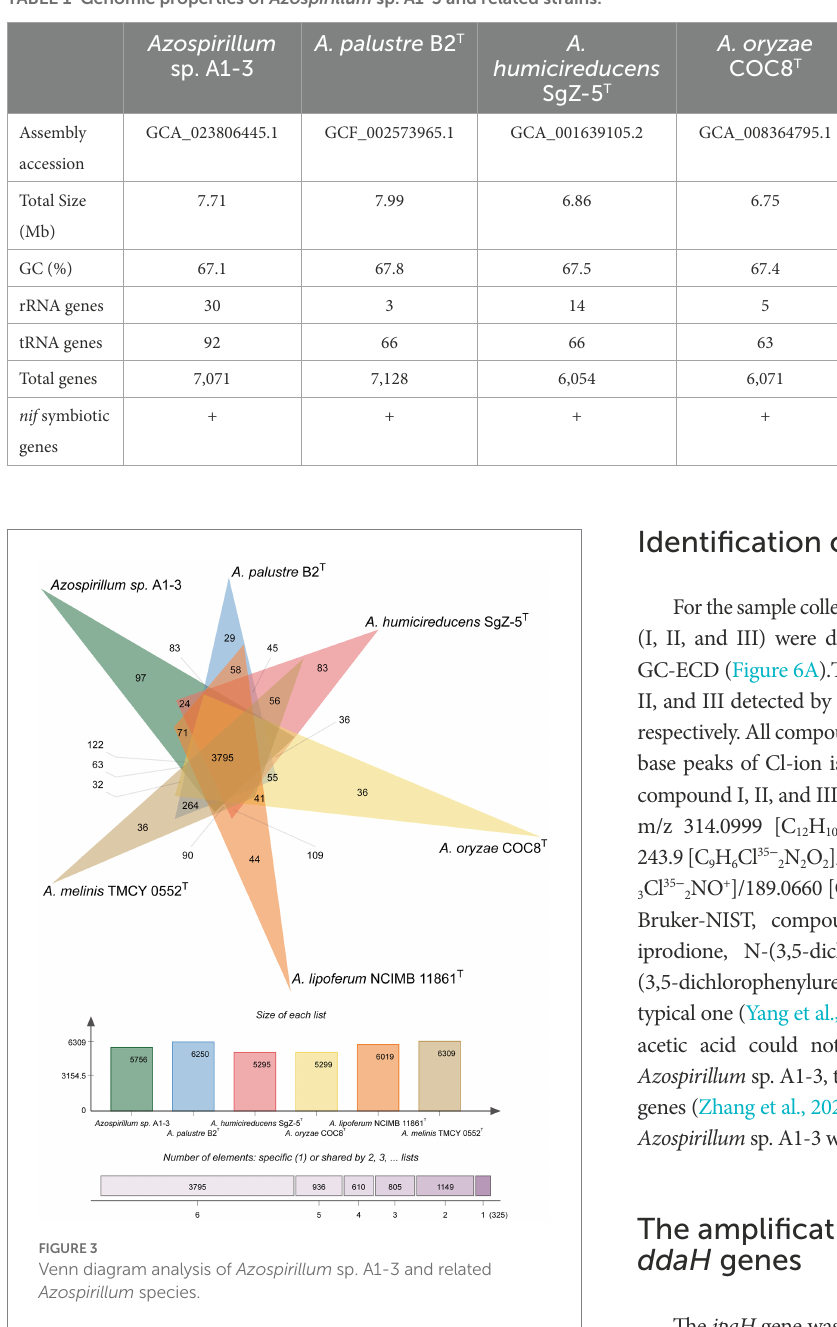
TABLE 1 Genomic properties of Azospirillum sp. A1-3 and related strains.